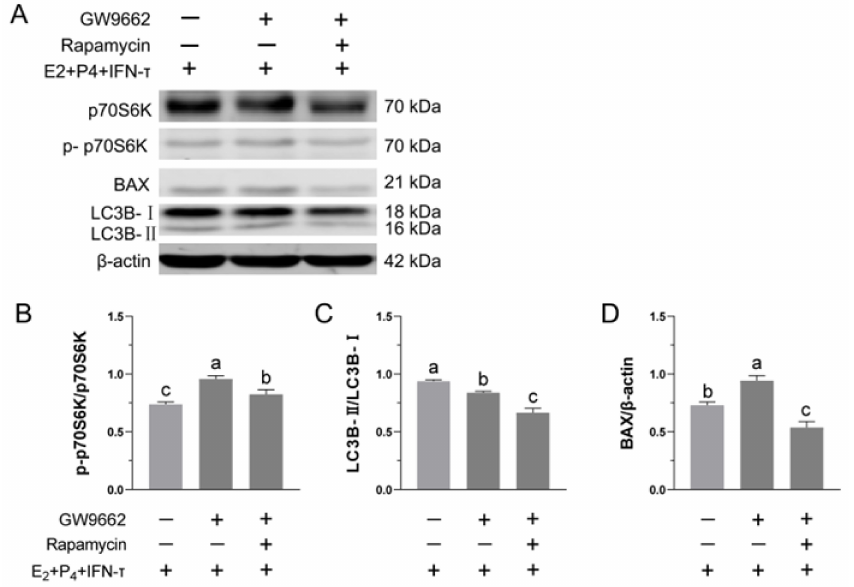
Figure 7. Blocking the mTOR pathway can alleviate the adverse effects of PPAR γ inhibition: ( A ) Pro- tein levels of p70S6K, p-p70S6k, LC3B-I, LC3B-II and BAX were determined by Western blotting (Figure S2). ImageJ grayscale intensity measurements were performed on protein bands, and the ratios of ( B ) p-p70S6K/p70S6K, ( C ) LC3B-II/LC3B-I, and ( D ) BAX/ β -actin were calculated. Data are expressed as the mean ± SD of three independent trials. Different letters above the bars indicate significant differences ( p <